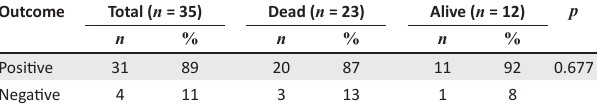
TABLE 6: Outcome by human immunodeficiency virus (HIV) status in adults.